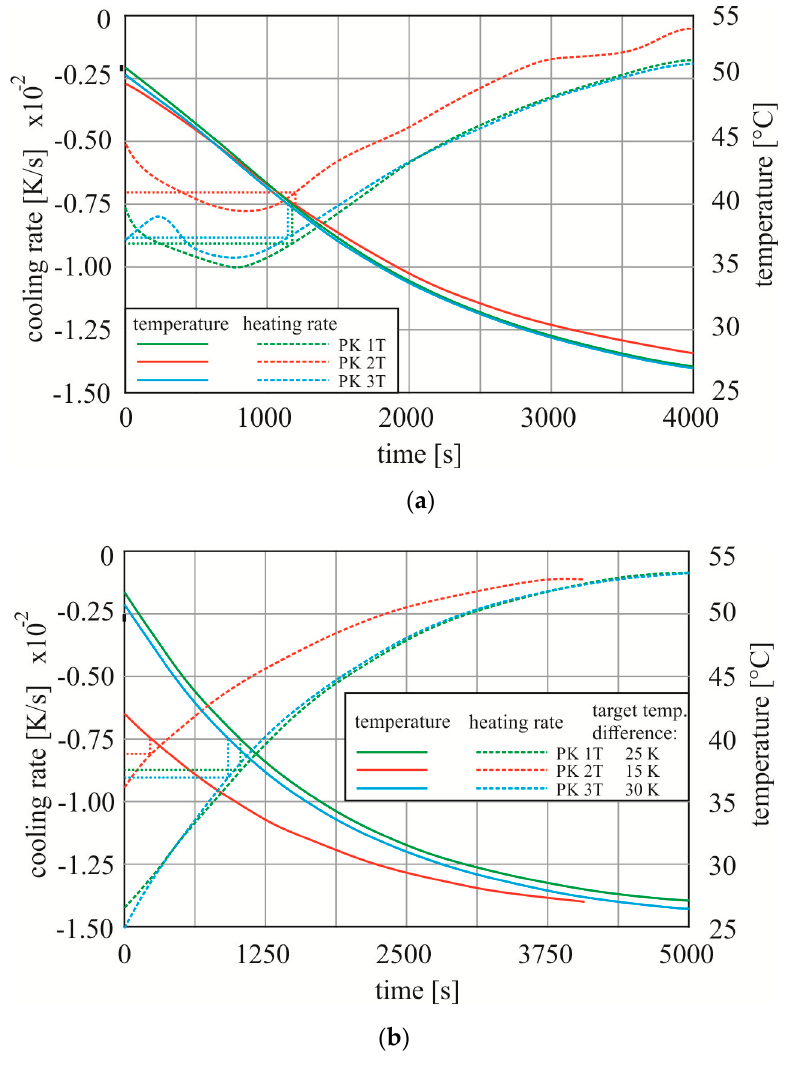
Figure 7. ( a ) Cooling inside test specimens after heating in oven; ( b ) Cooling inside test specimens after heating due to fatigue